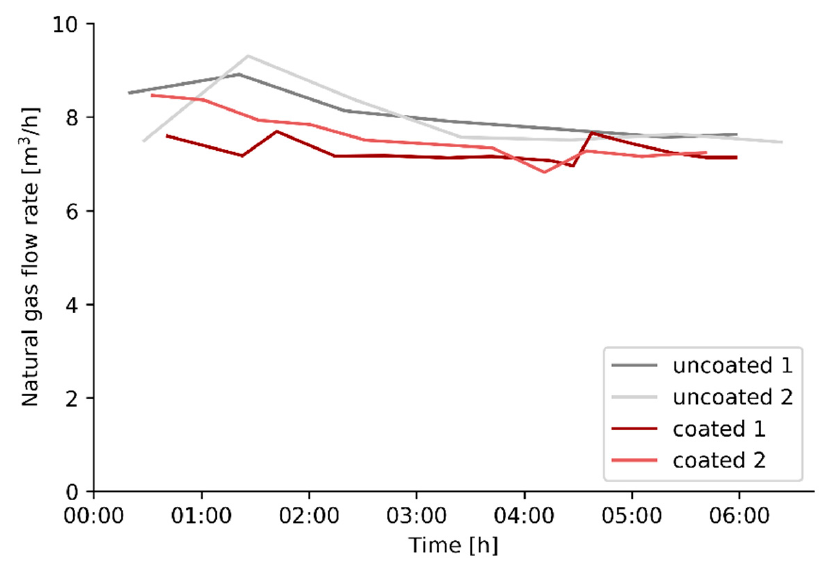
Figure 8. Natural gas flow rate to the entire pilot unit as a function of time for the different experi- ments.